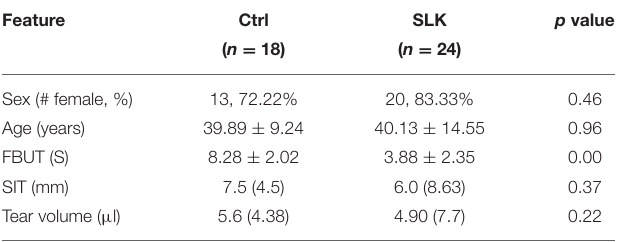
TABLE 1 | Demographic characteristics of study subjects in the SLK and Ctrl groups.